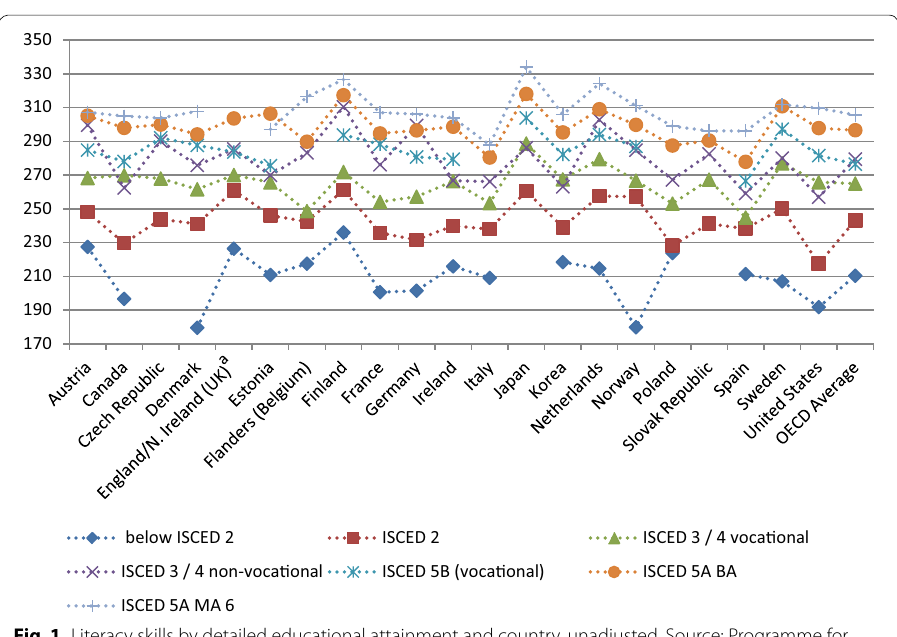
Fig. 1 Literacy skills by detailed educational attainment and country, unadjusted. Source: Programme for the International Assessment of Adult Competencies (PIAAC), 2012; own calculations. Notes ISCED national Standard Classification of Education. Sample is restricted to adults aged 25–65 years in 2011 and to respondents who completed their highest educational qualification in the country they participated in for PIAAC. a ISCED 5A BA for England/Northern Ireland includes both BA and MA, as well as ISCED